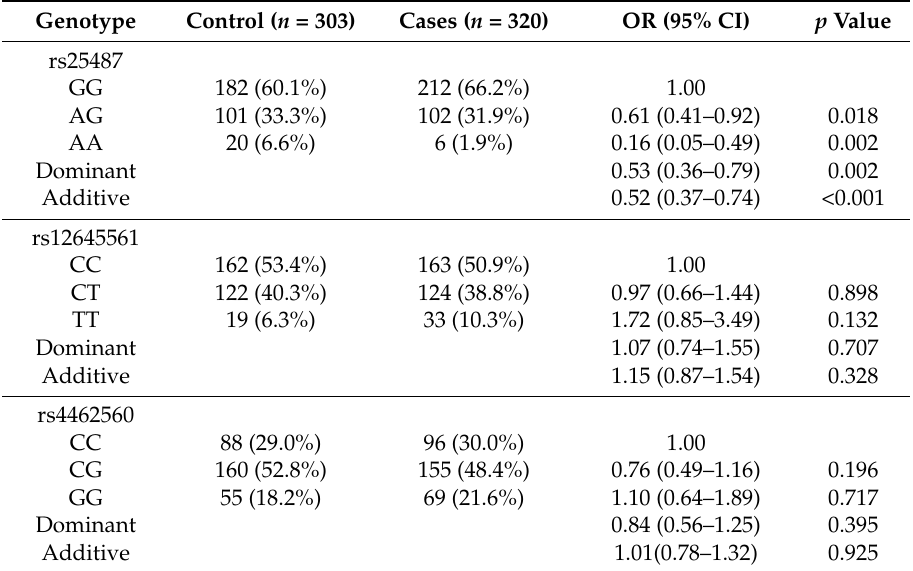
Table 2. Association of SNP genotypes with ischemic stroke (IS)